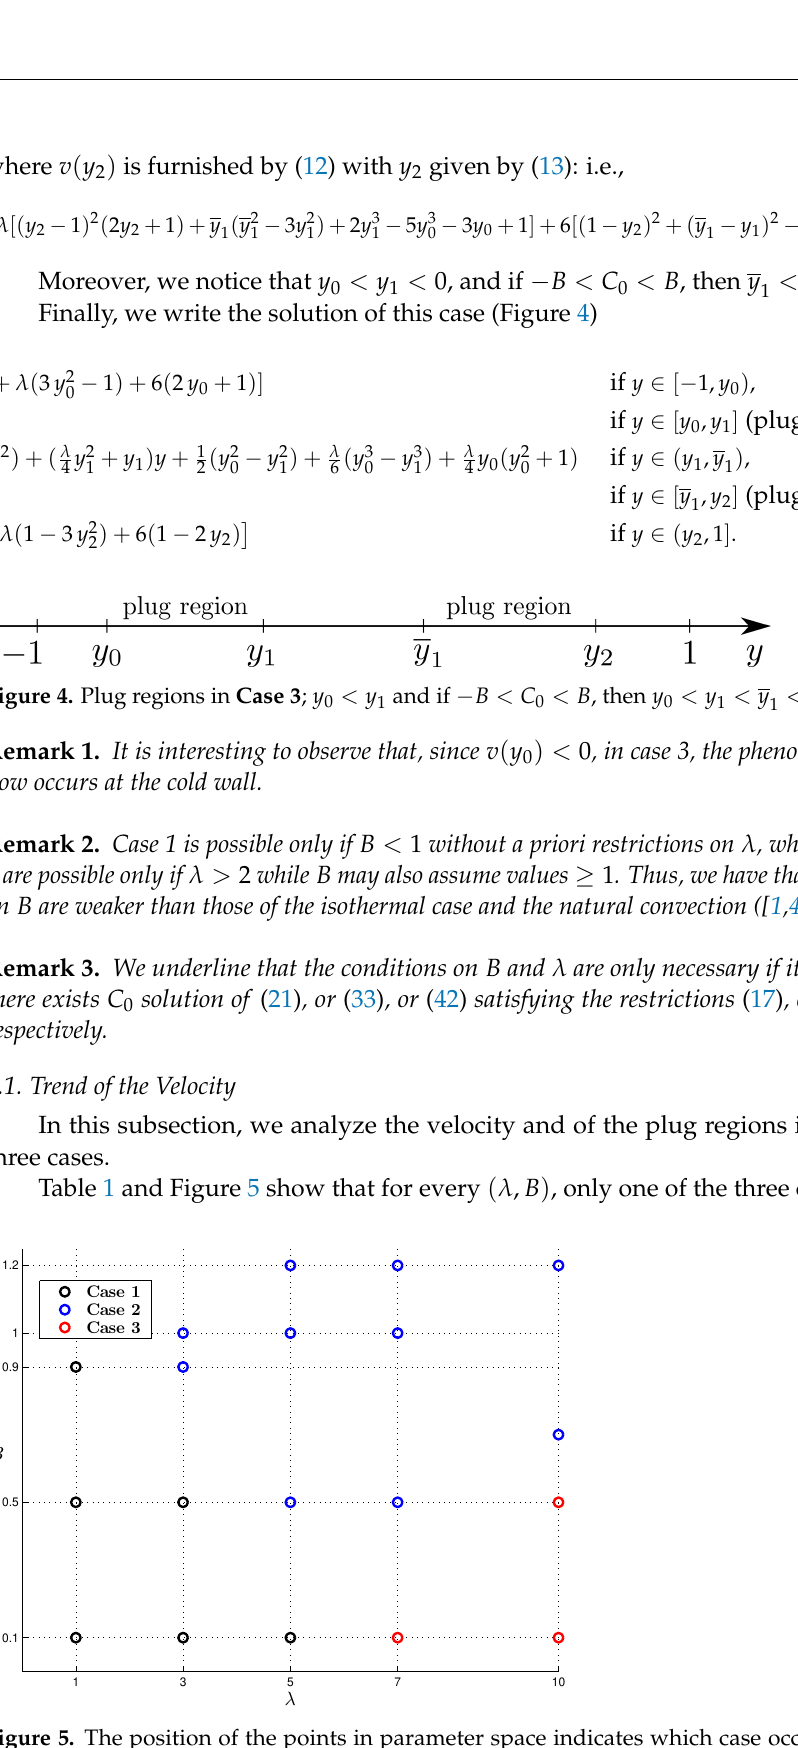
Figure 5. The position of the points in parameter space indicates which case occurs. The picture shows only the couples ( λ , B ) of Table